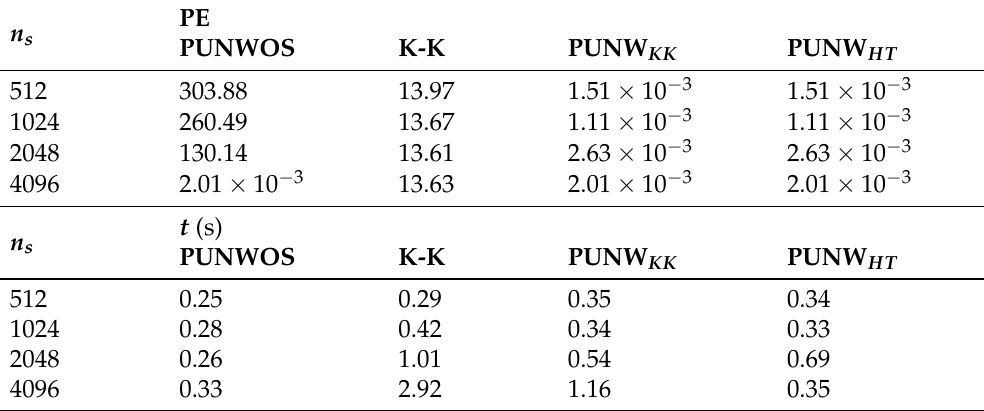
Figure 1. Path γ ( ω ) traced by Equation (8) on the complex punctured plane ˙ C for the slab with d ef f = 180 nm. Green diamond marker: path starting point, ω = 0 Hz. Red diamond marker: path end point, ω = 1 PHz. Table 2. Percentage Error (PE) and computational time t for the slab with d ef f = 180